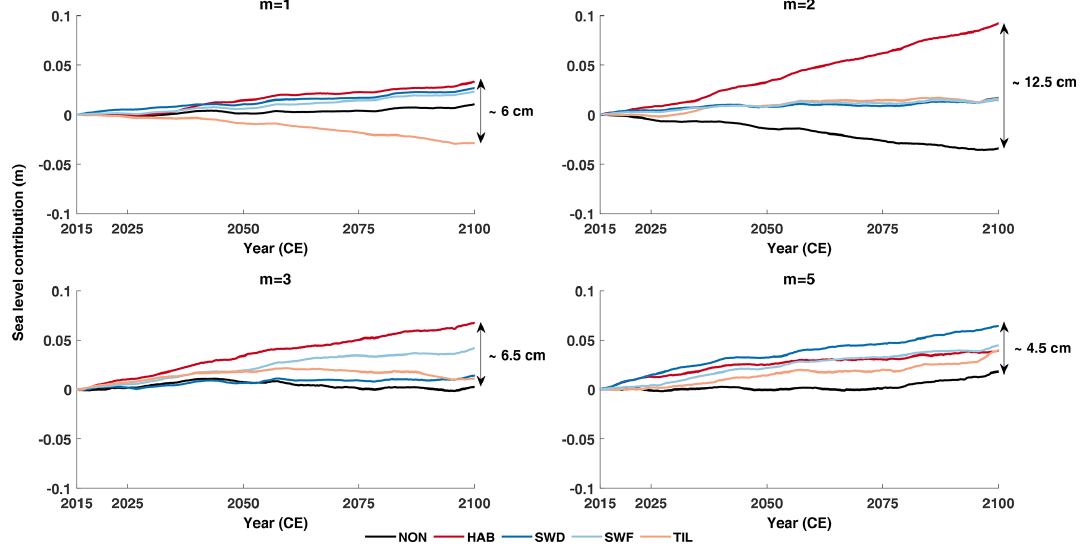
Figure 8. Sea level contribution from the Antarctic ice sheet until 2100 following HadGEM2 in the RCP8.5 scenario. Each graph gives the results for one exponent of the basal sliding law, and line colours represent the different subglacial models (Table